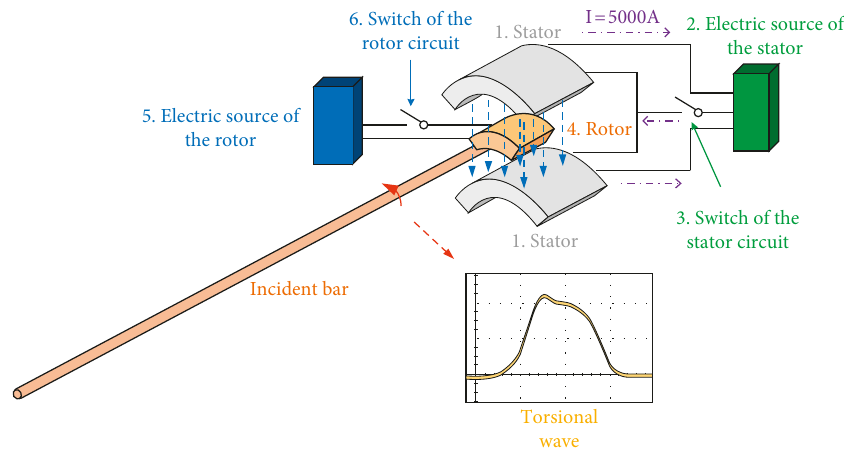
Figure 10: The electromagnetic loading TSHB